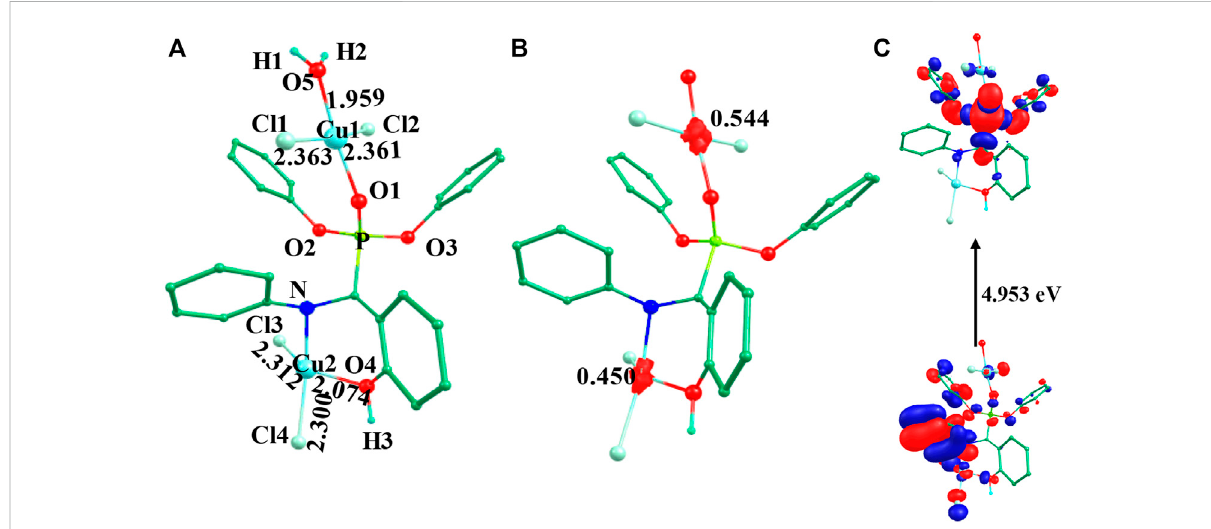
FIGURE 2 B3LYP-D2 (A) optimized structure, (B) spin density plot and (C) HOMO-LUMO gap of the species 3 IV (Bond lengths are in Å).